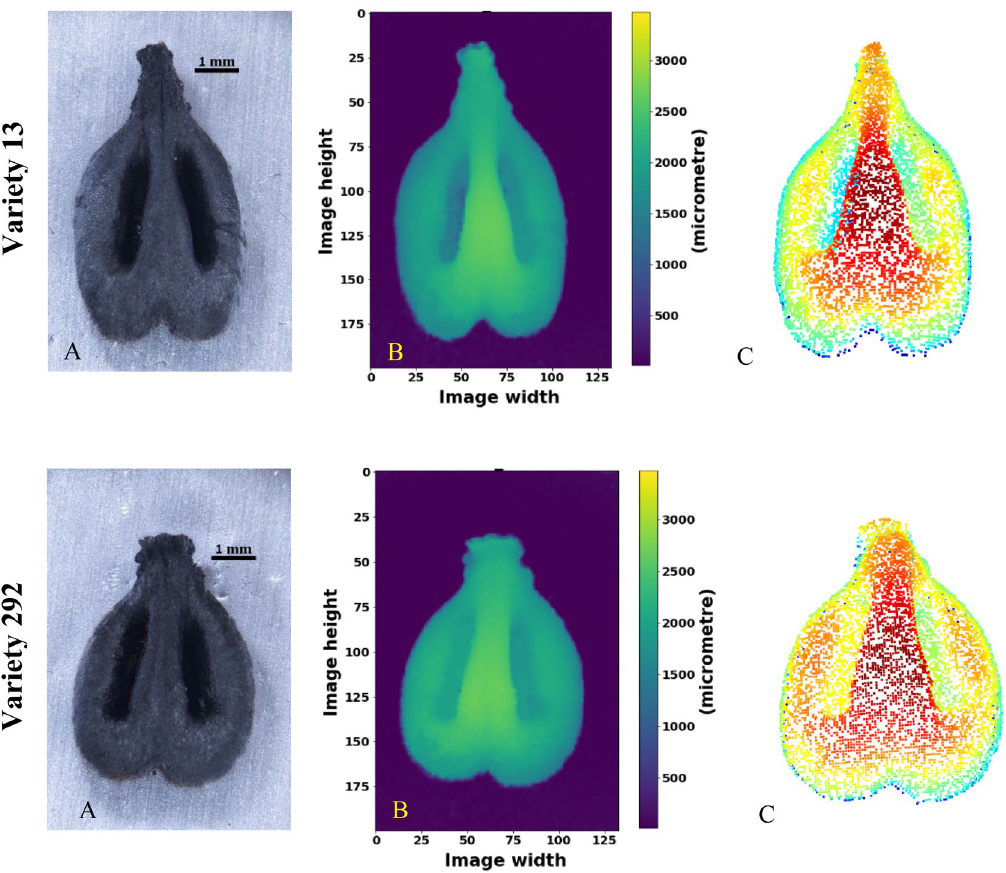
Figure 3. Acquisition of 3D data for charred grape pips. ( A ) High quality focused 3D image; ( B ) height map, and ( C ) points cloud of two varieties of charred